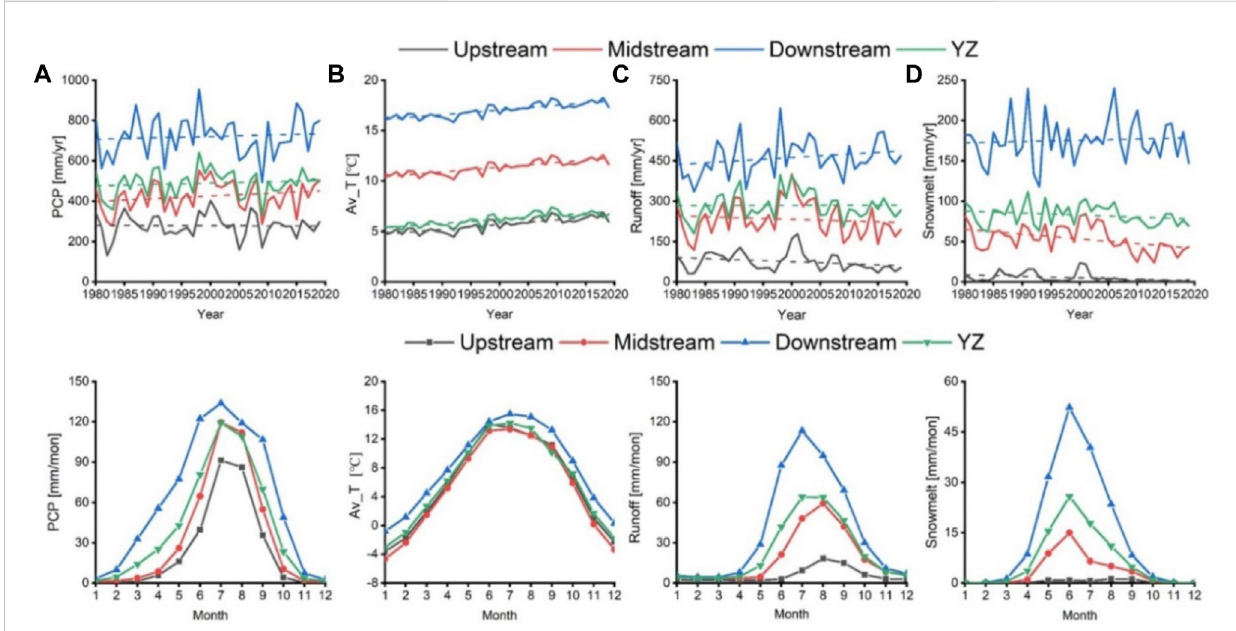
FIGURE 4 Temporal distribution of (A) precipitation (PCP), (B) average temperature (Av_T), (C) runoff, and (D) snowmelt at annual and monthly scales in the historical period (1980 –